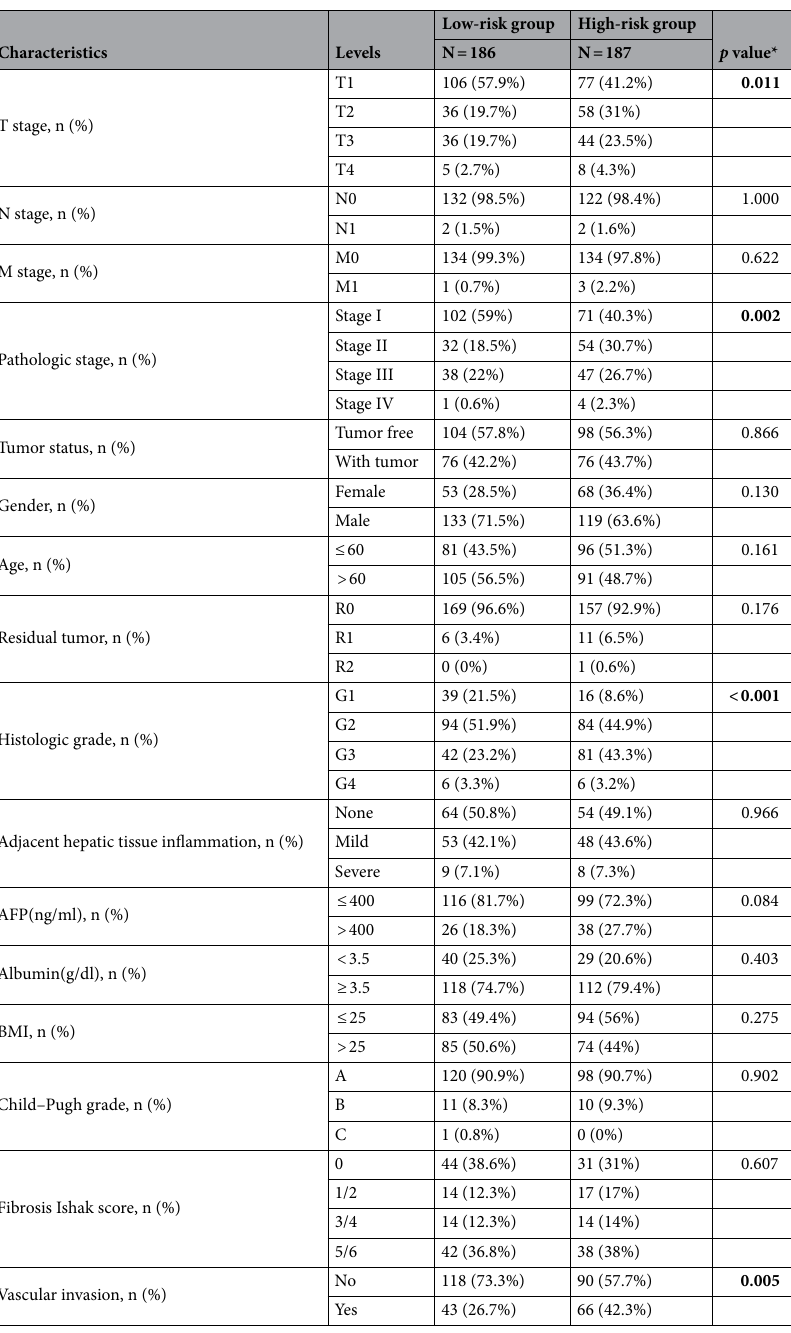
Table 4. Baseline characteristics of patients (TCGA-LIHC). Data are presented as n (%). LIHC liver hepatocellular carcinoma. *Compared with each group (Fisher exact test, or Pearson’s chi-square test). p value < 0.05 was considered statistically significant (highlighted in